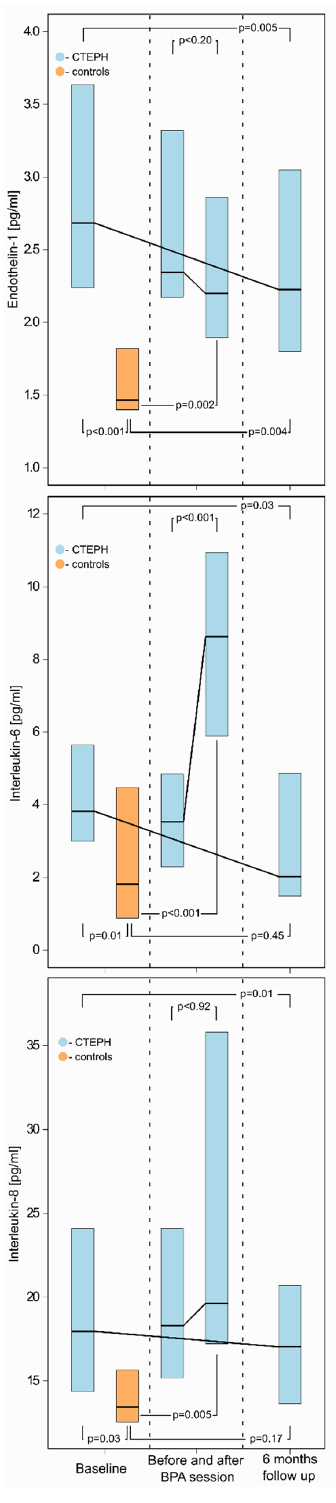
Figure 3. Serum concentrations of endothelin 1, interleukin 6, and interleukin 8 at different time points (baseline, after single BPA session, after completion of BPA treatment) during BPA treatment as compared to control group. IL-6 and IL-8 levels normalized after completion of BPA treatment. The difference between the two time points in the CTEPH group was determined using the Wilcoxon matched-pairs signed-rank test. The difference between the CTEPH group and the controls was determined using the Mann–Whitney U test.